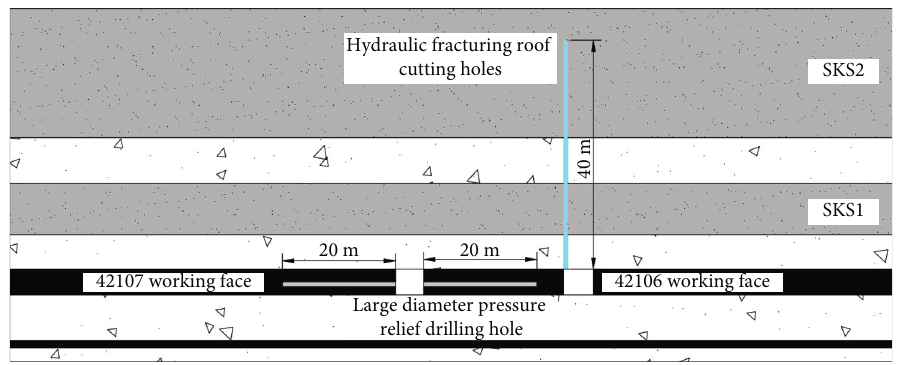
Figure 13: Destressing method of the 42107 tailentry surrounding rock.